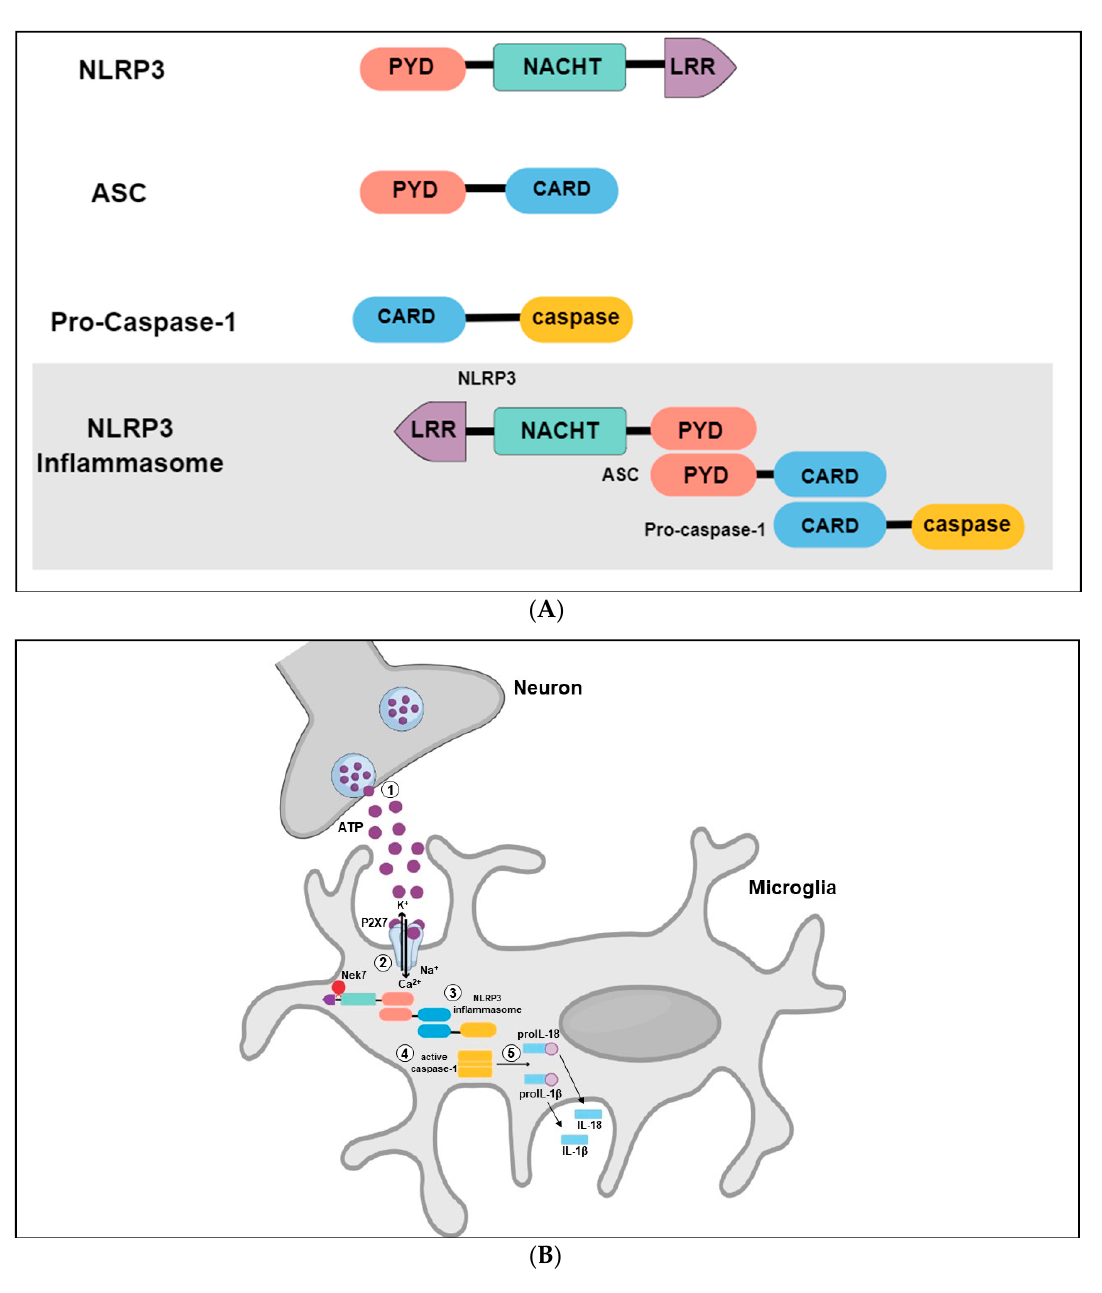
Figure 3. P2X7R-mediated NLPR3 inflammasome activation. ( A ) NLRP3 is composed by an N-terminal pyrin domain (PYD), a central nucleotide-binding-and-oligomerization (NATCH) domain, and a C-terminal leucine-rich repeats (LRR) domain. PYD domain recruits the apoptosis-associated speck-like protein (ASC) that contains a caspase recruitment domain (CARD). This complex recruits the procaspase-1. Together, these components constitute the NLRP3 inflammasome. ( B ) 1. High ATP levels released from neurons or astrocytes reach P2X7R located in microglia; 2. P2X7R stimulation elicits K + e ffl ux, which may trigger NLRP3 inflammasome assembly and activation through NIMA-related serine / threonine kinase 7 (Nek7) binding; 3. NLRP3 inflammasome mediates the activation of caspase-1; 4. Caspase-1 induces the maturation of interleukins (IL) by cleaving pro-IL-1 β and pro-IL-18 in IL-1 β and IL-18, respectively; 5. Finally, the mature form of cytokines are